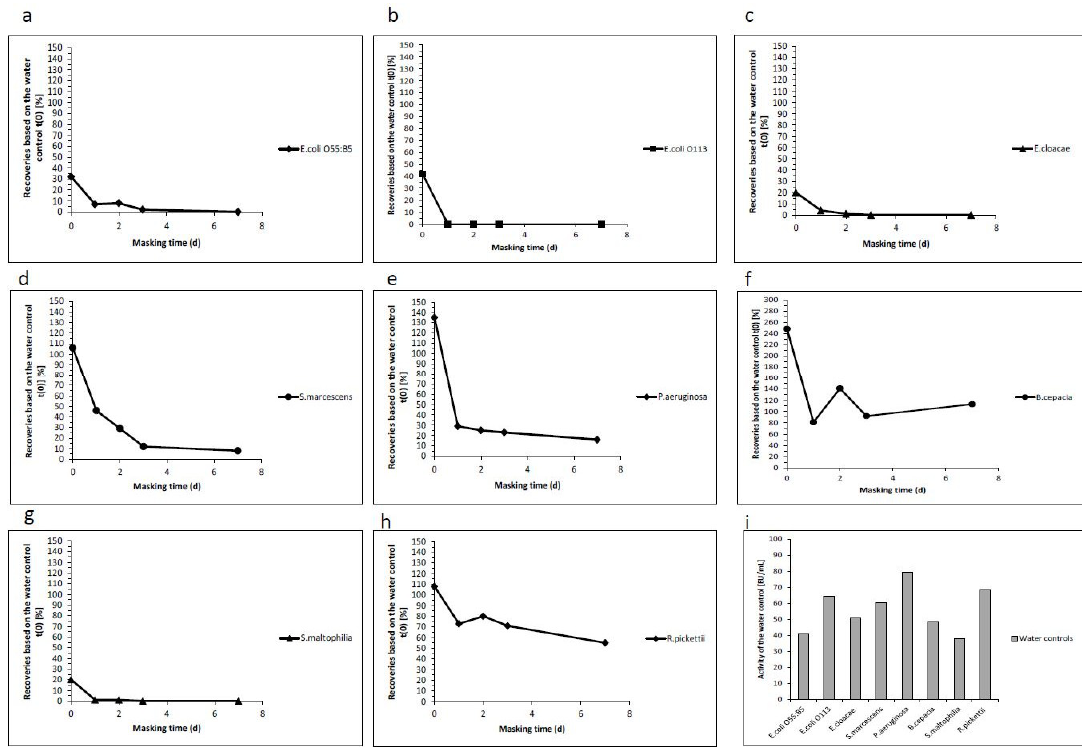
Figure 2. Hold time study using NOEs of different species. Endotoxin recovery over seven days at room temperature are shown for different species ( E. coli O55:B5 ( a ), E. coli O113 ( b ), E. cloacae ( c ), S. marcescens ( d ), P. aeruginosa ( e ), B. cepacia ( f ), S. maltophilia ( g ) and R. pickettii ( h )). For spiking, a 10-fold concentrated stock solution was prepared. The concentration of the water controls corresponding to the activities (EU/mL) are shown in ( i ). For the recovery experiments, the crude extracts were spiked into 0.05% (w/v) polysorbate 20 and 10 mM sodium citrate. The recoveries were determined after 0, 1, 2, 5 and 7 days. All recoveries were calculated based on the corresponding water control at time point 0.